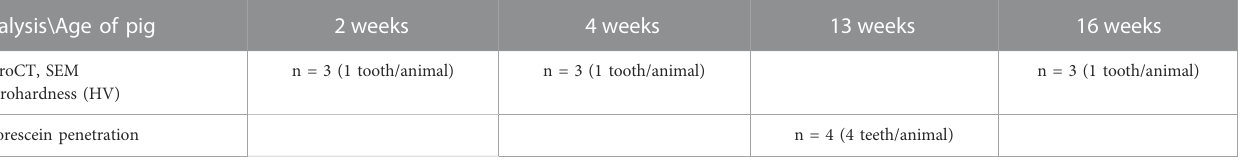
TABLE 1 Age and number of animals used for each experimental procedure. Analysis\Age of